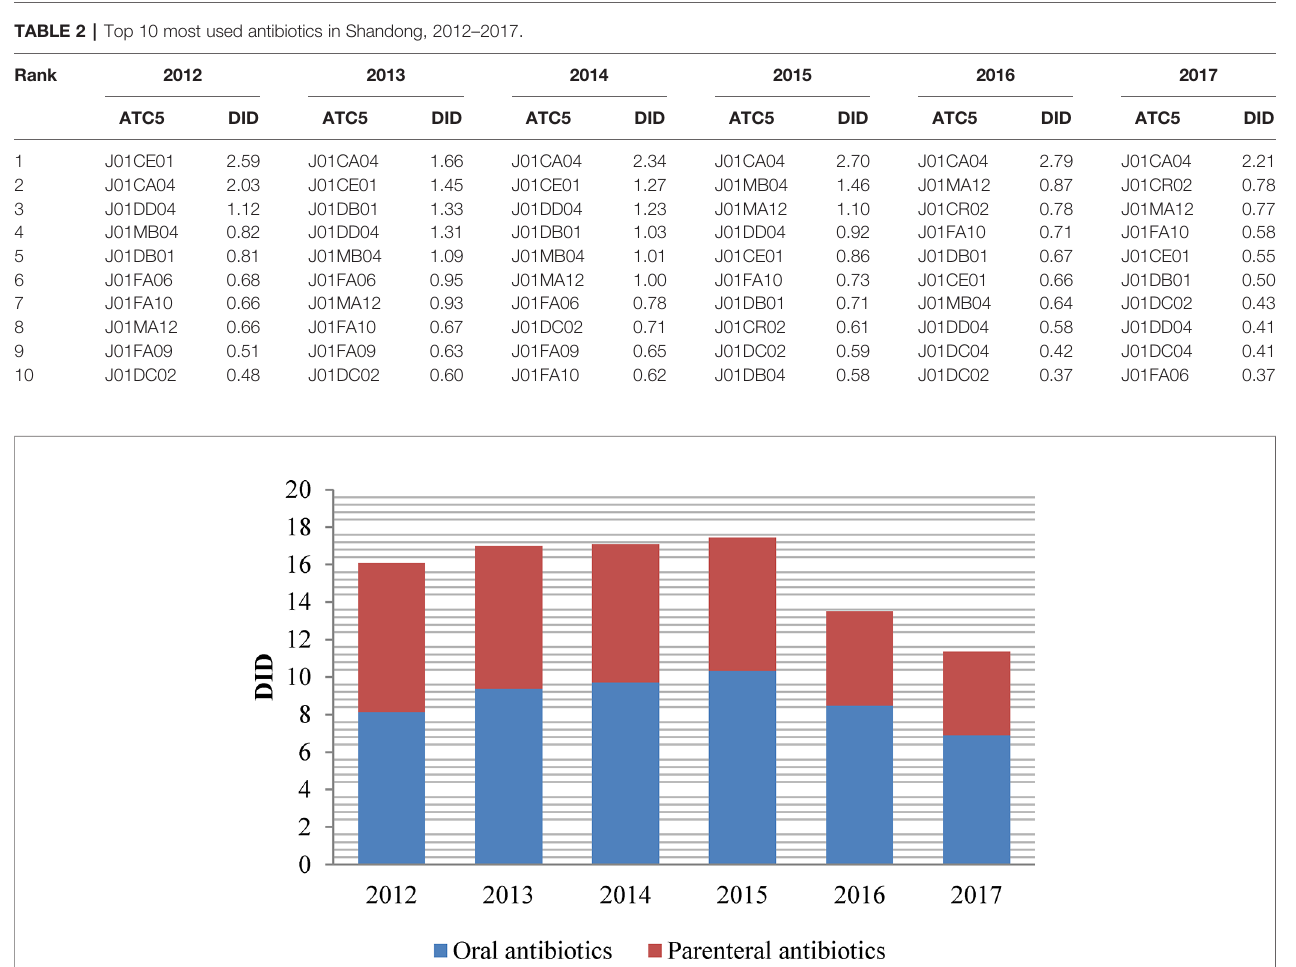
FIGURE 3 | Consumption of oral and parenteral antibiotics in Shandong, China, 2012 –